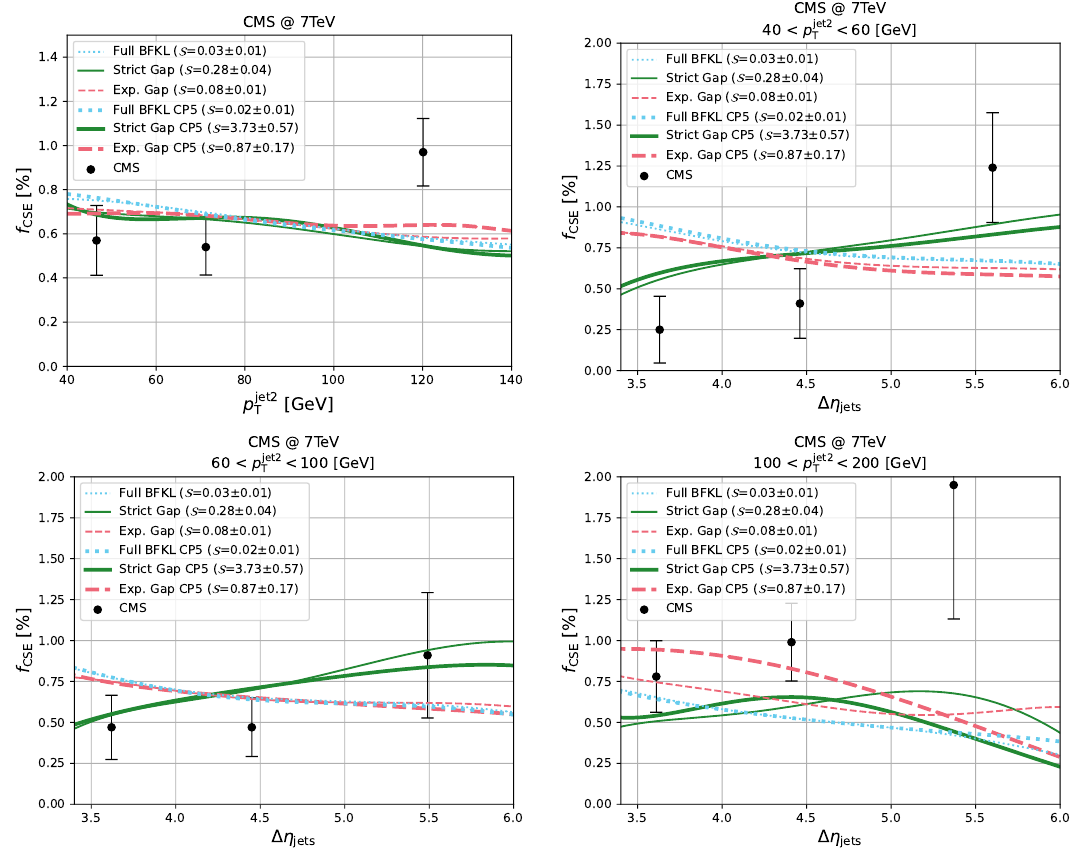
(top left) and ∆ η with p jet2 ∈ [40; 60] GeV jets T T ∈ [100; 200] GeV (bottom right) compared T